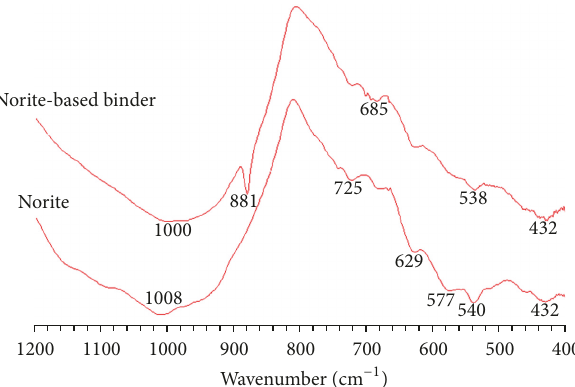
Figure 6: FTIR of aluminosilicates of the solid precursor and the norite-based binder, which was cured for 7 days at 87 ∘ C and ambient